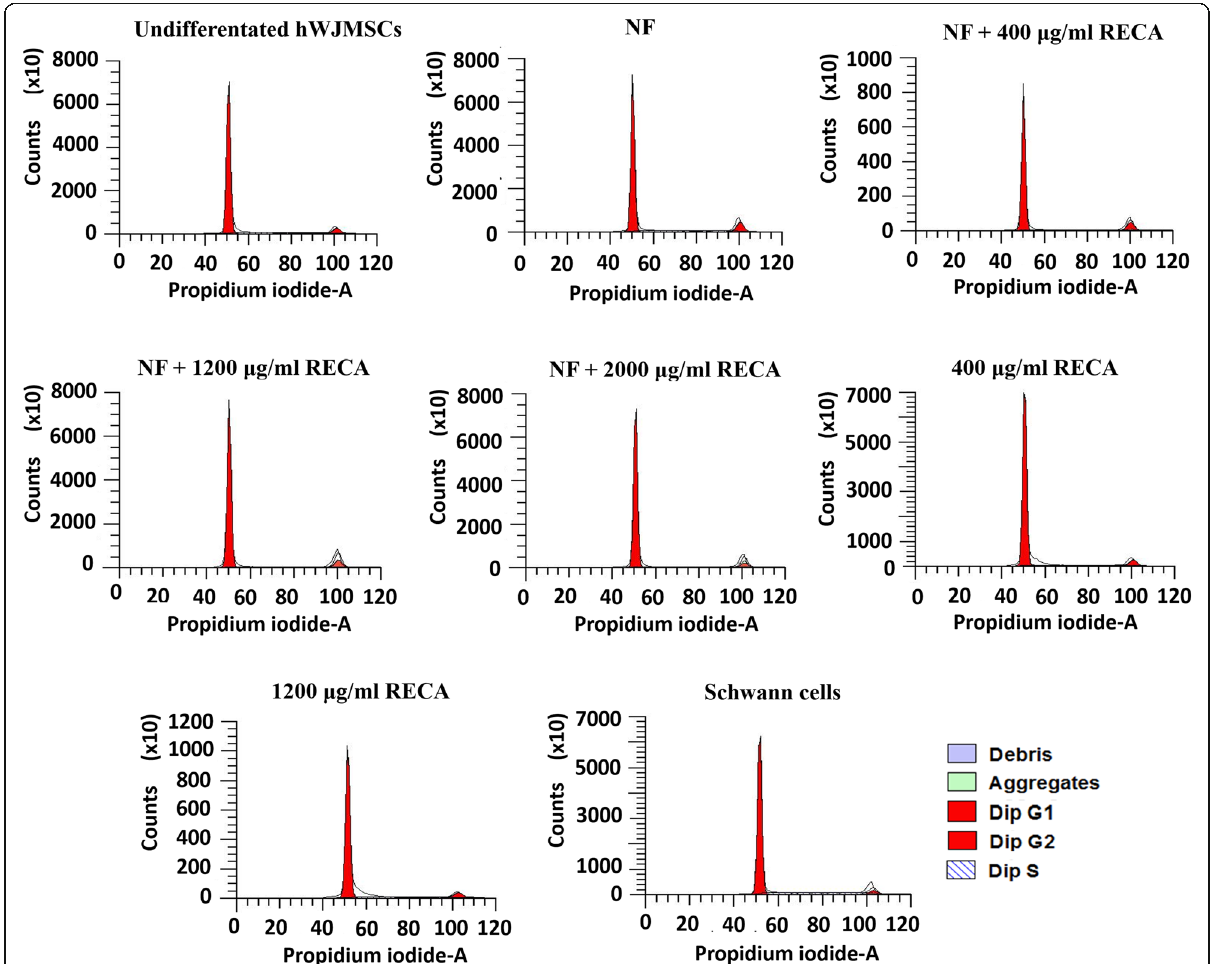
Fig. 10 DNA histogram showing the distribution of the hWJMSC population in each experimental group for different cell cycle phases (G 0 /G 1 , S and G 2 /M phase). The x-axis represents the relative fluorescence intensity proportional to the DNA content. A similar cell cycle pattern was observed in all experimental groups, and most of the cultured cells were in the G 0 /G 1 phase ( n =